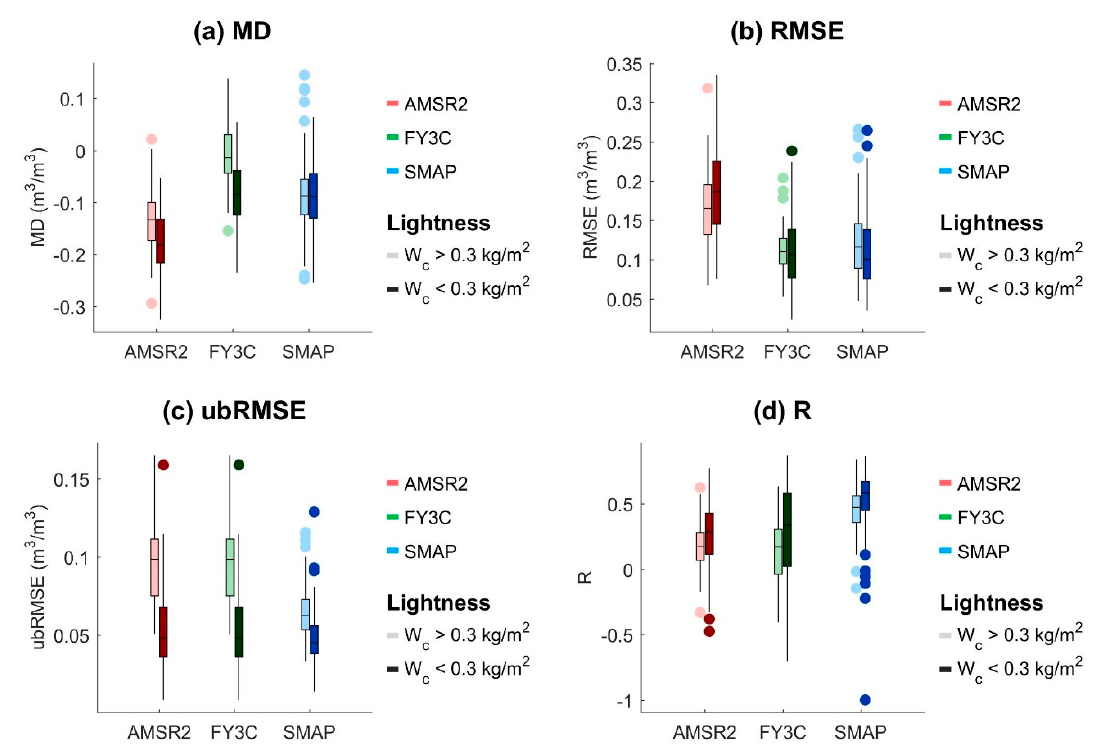
Figure 12. The temporal performance of the soil moisture products from FY-3C, AMSR2, and SMAP under the two different vegetation water content (VWC, W c ) conditions. VWC was estimated using Equations (1) and (2). In total, 113 stations were used to assess the statistical parameters. The VWC of about one-third of the valid dates was lower than 0.3 kg/m 2 . Table 8. The statistical indicators for FY-3C, AMSR2, and SMAP soil moisture retrievals under the two contrasting vegetation water content (VWC, W (cid:2913) ) conditions.